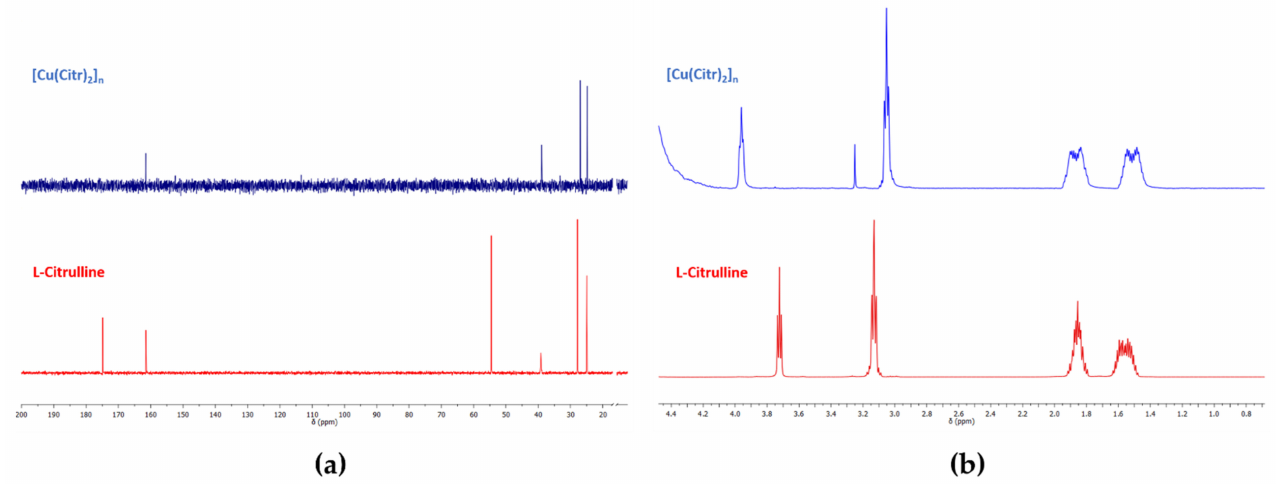
Figure 8. ( a ) 13 C NMR spectrum of [Cu(Citr) 2 ] n in D 2 O, and ( b ) 1 H NMR spectrum of [Cu(Citr) 2 ] n in D 2